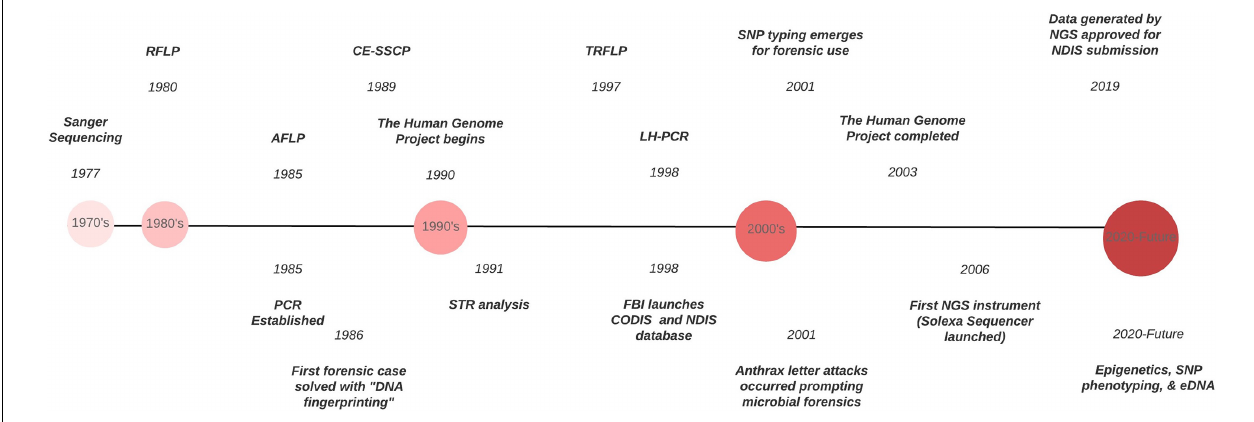
FIGURE 1 | Timeline of the evolution of DNA typing technologies from the 1970’s to the present.